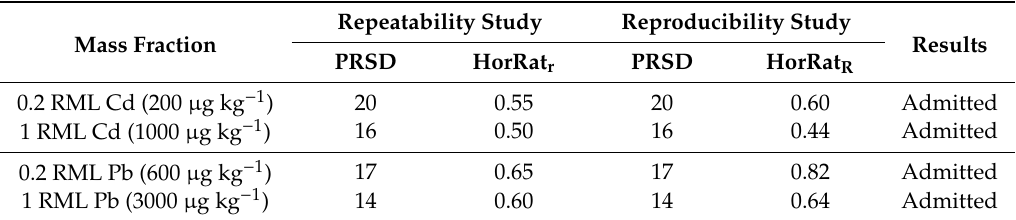
Table 3. Calculated PRSD, HorRat r , HorRat R